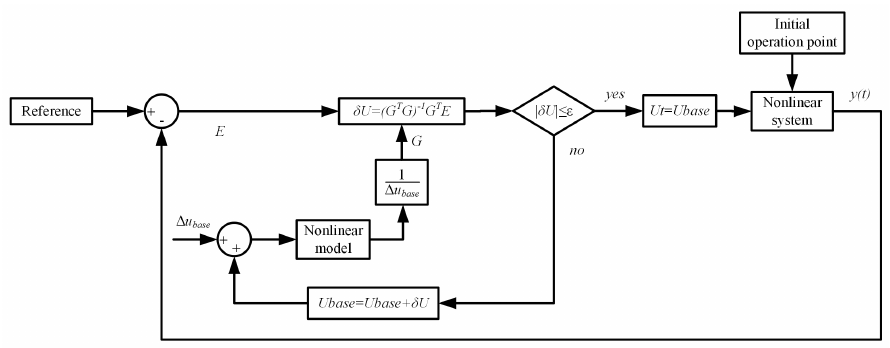
Figure 2. The flow chart of nonlinear